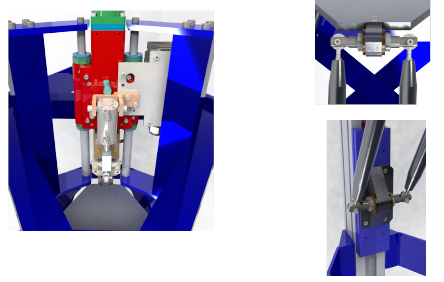
Figure 10. Extruder and universal joints of the linear